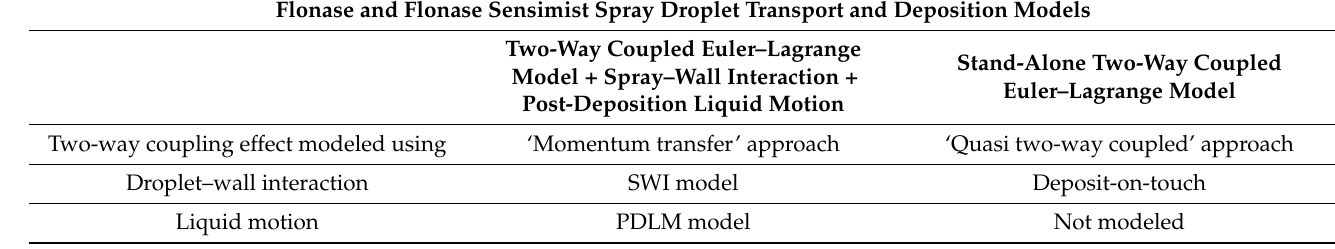
Table 2. Different spray transport and deposition modeling approaches used in this